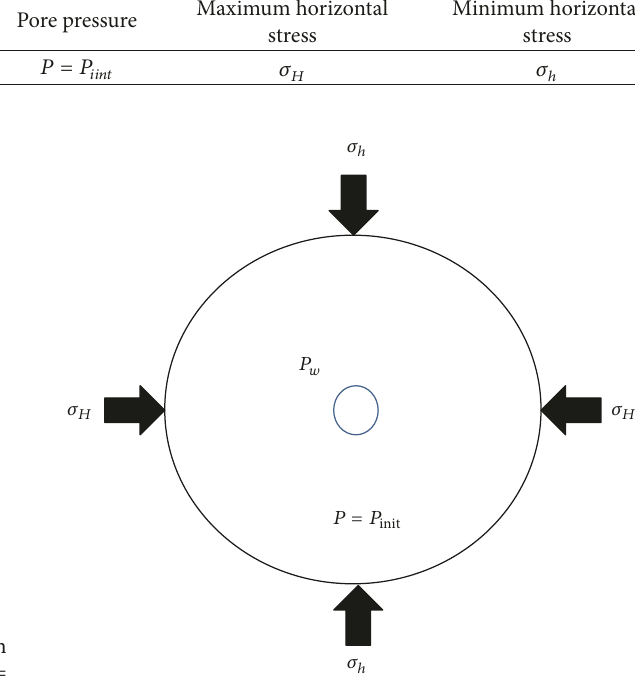
Figure 21: Schematic of the